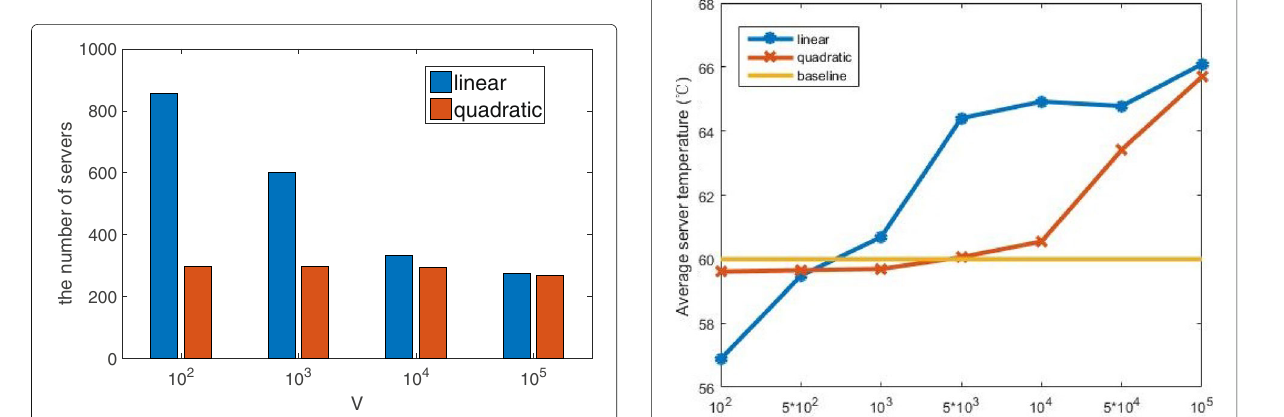
Fig. 14 The average server temperature vs.